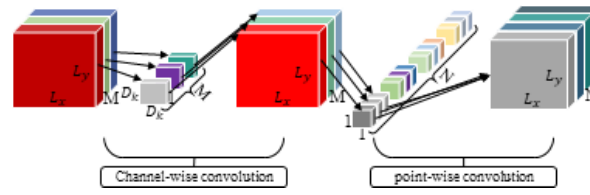
Figure 6. Deep separable convolution